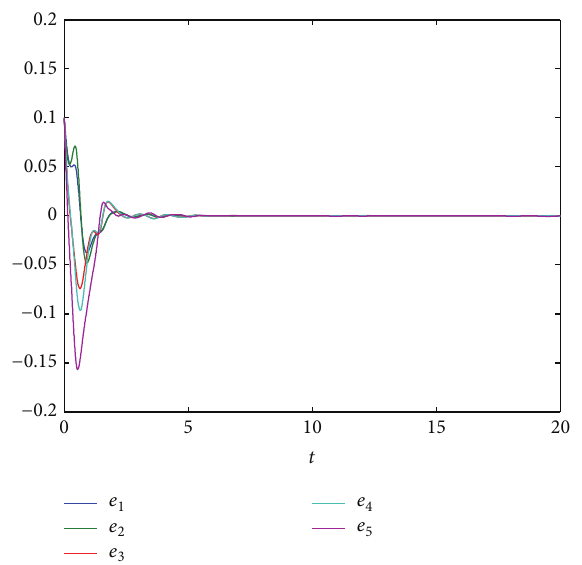
Figure 7: Curves of the synchronization errors of the systems (14) and